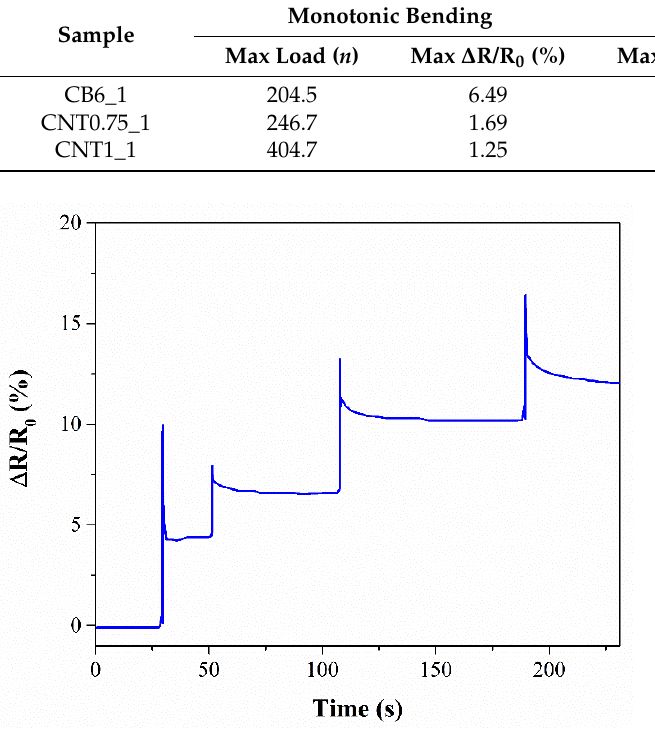
Figure 9. Electrical resistance variation vs. time of CB6_1 under subsequent impacts.